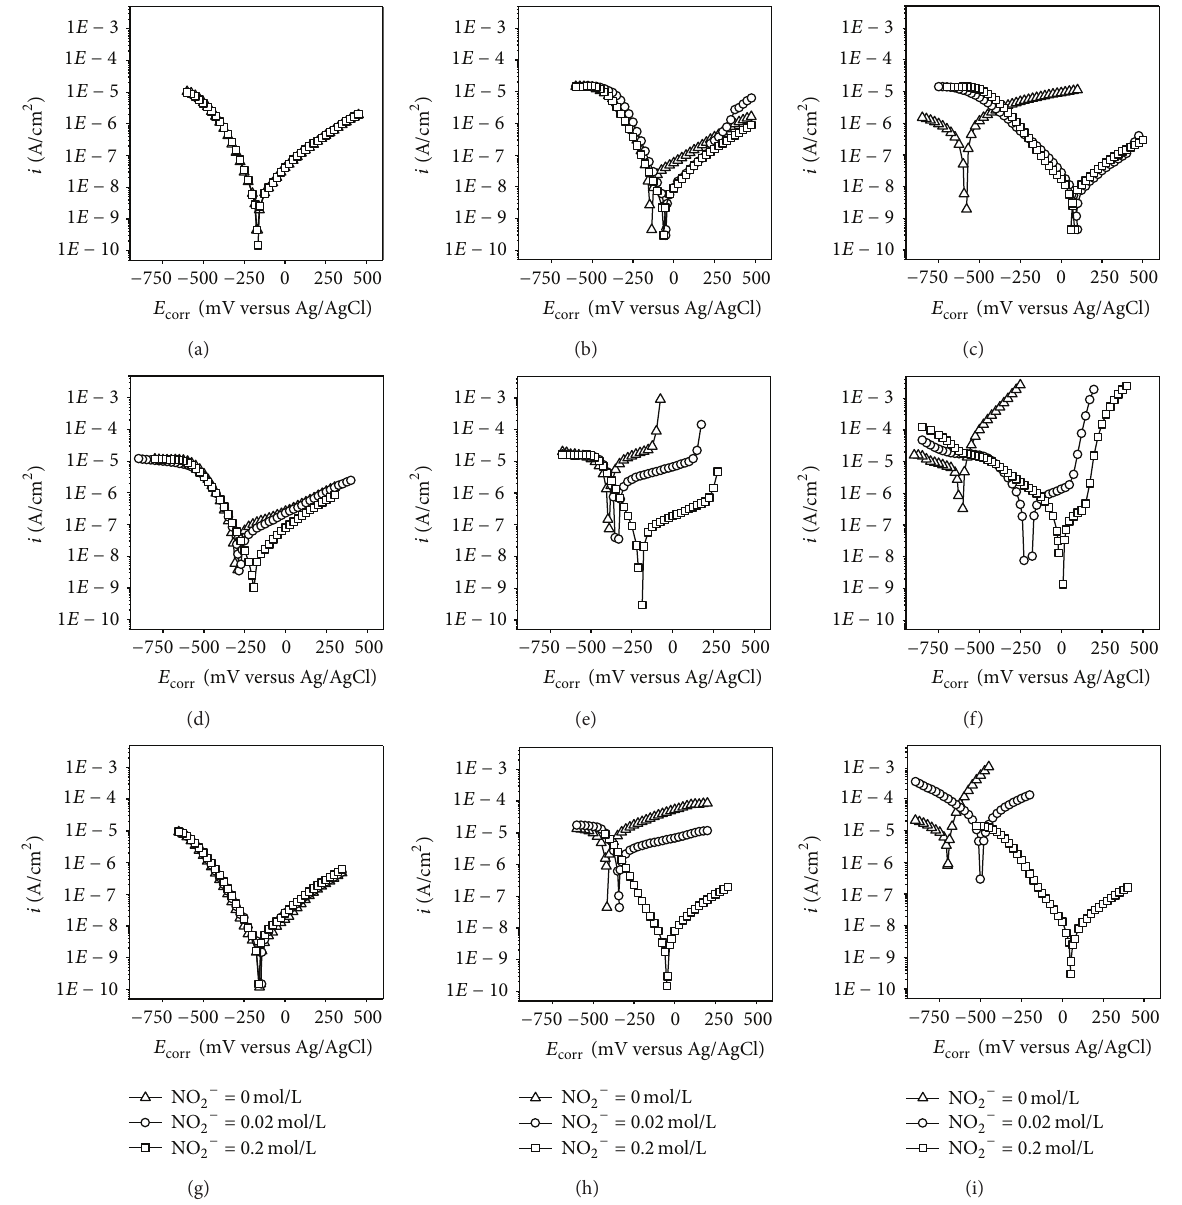
Figure 15: Effect of NO 2− concentration on anodic and cathodic polarization curves of steel immersed in different pH solutions with and without0.1mol/LCl − orSO 42− .(a)pH12.6withoutCl − orSO 42− ,(b)pH10.3withoutCl − orSO 42− ,(c)pH8.1withoutCl − orSO 42− ,(d) pH 12.6 with 0.1mol/L Cl − , (e) pH 10.3 with 0.1mol/L Cl − , (f) pH 8.1 with 0.1mol/L Cl − , (g) pH 12.6 with 0.1mol/L SO 42− , (h) pH 10.3 with 0.1mol/L SO 42− , and (i) pH 8.1 with 0.1mol/L SO 42−